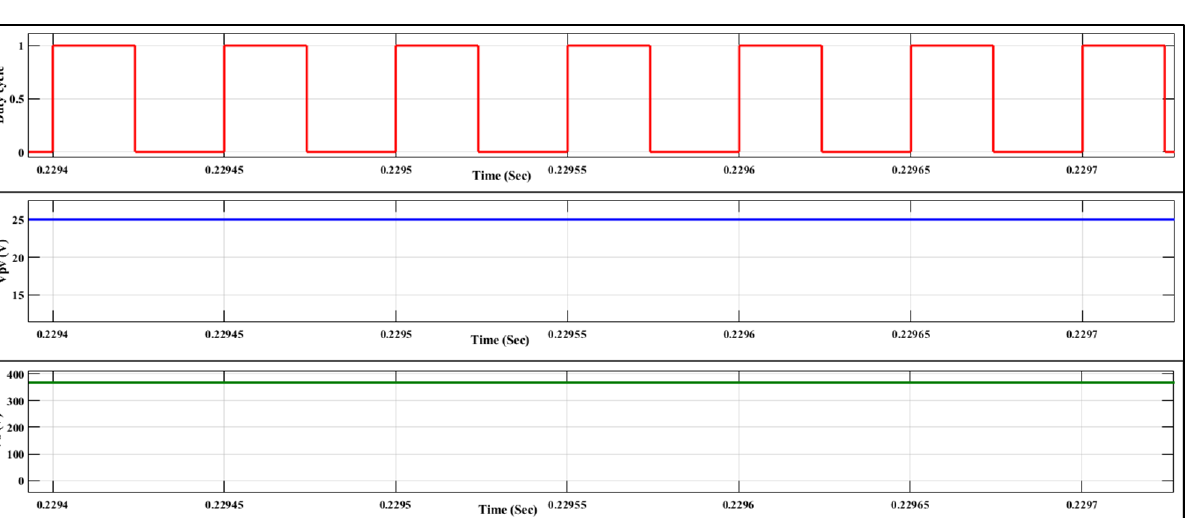
Figure 11. Simulated waveform for solar PV module output voltage (V pv ) and output voltage (V o ) of the proposed HVGSU converter at the 0.44 duty cycle. Figure 12 shows the simulated waveforms for the solar PV voltage (V pv ) and output voltage (V o ) for the proposed HVGSU converter. When the solar PV voltage (V pv ) is 35 V and the duty cycle is controlled to 0.39 in order to achieve a DC microgrid voltage V o = 380 V (as shown in Figure 1), the duty cycle is smaller, which will reduce switching losses and make the converter more e ffi cient.